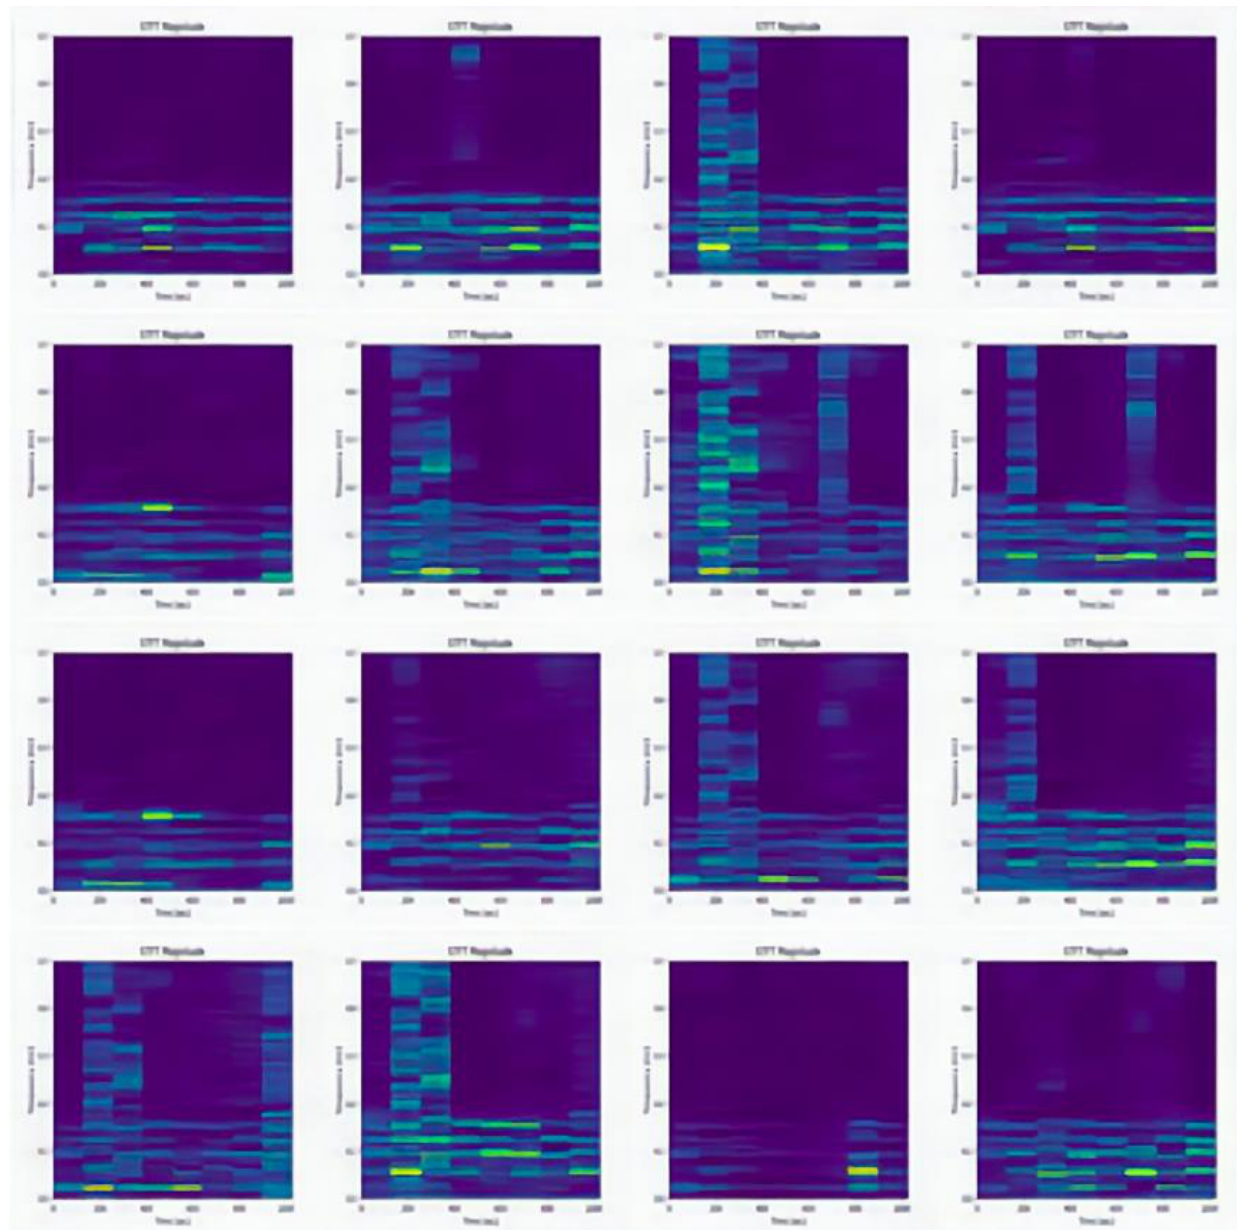
Figure 12. DCGAN generated partial domain A dummy sample. Table 6. Classification accuracy of all methods